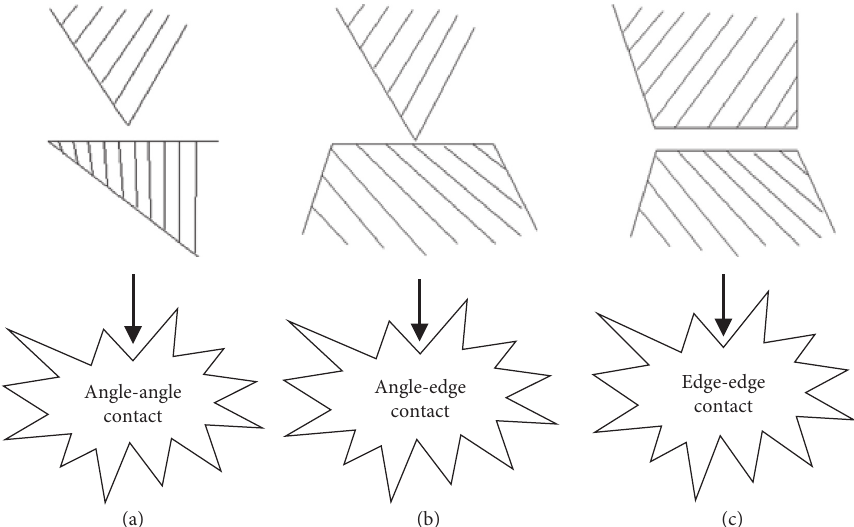
Figure 5: Block’s contact of discontinuous deformation analysis for rock failure (DDARF). (a) Angle-angle contact. (b) Angle-edge contact. (c) Edge-edge contact.